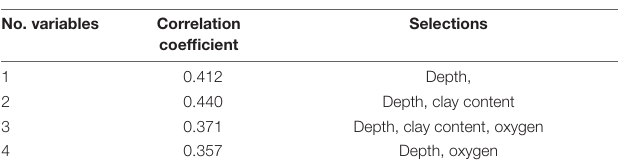
TABLE 4 | Correlations of bottom fauna with environmental data matrices. (a) Combination of environmental variables yielding best matches of abundance (ind. sample − 1 ) of macrofaunal taxa and environmental data similarity matrices (BIO-ENV